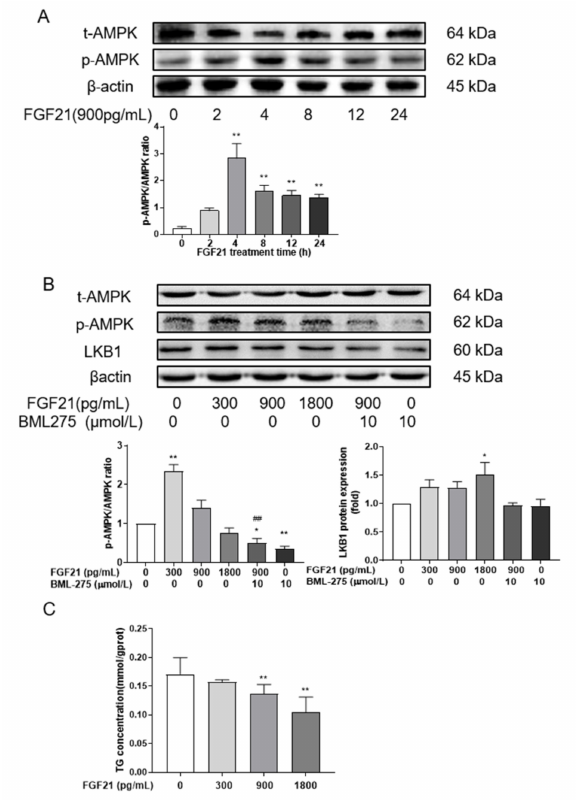
Figure 2. FGF21 regulates lipid accumulation by modulating AMPK phosphorylation. Time ( A ) and dose ( B ) effects of FGF21 on AMPK phosphorylation in hepatocytes; the content of intracellular TG ( C ) was detected after being treated with FGF21 for 4 h. Three independent experiments were performed. Statistically significance was indicated: *, p < 0.05; ** and ## , p < 0.01; * was compared with control group, # was compared with 900 pg/mL